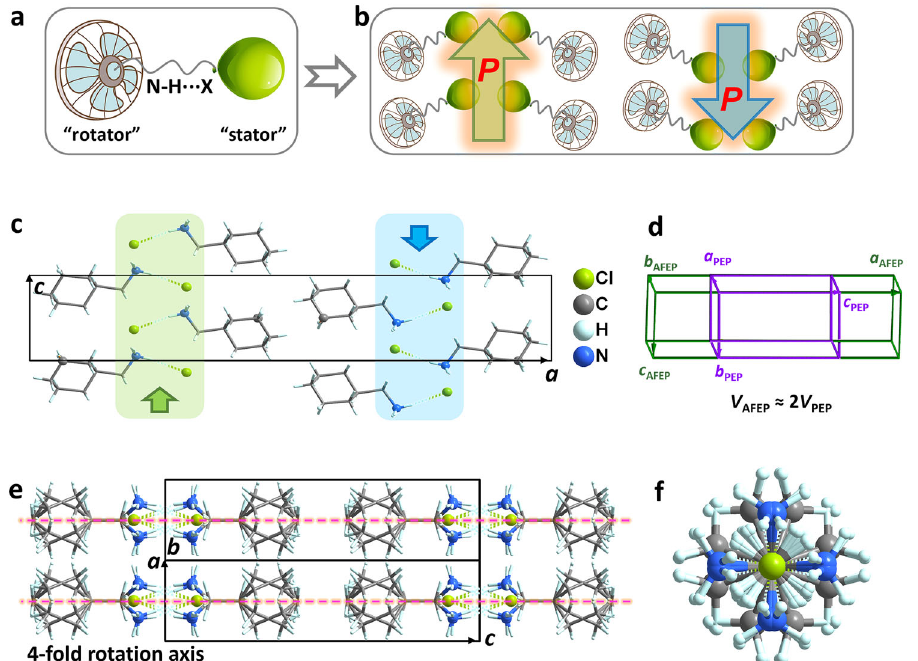
Fig. 2 | Crystal structures of binary solid solutions. a , b Schematic diagram of CMBr x I 1 − x and CMBr x Cl 1 − x binary solid solutions. The organic cations afford a driving force to trigger phase transitions. c Projection of AFE structure of CMC at